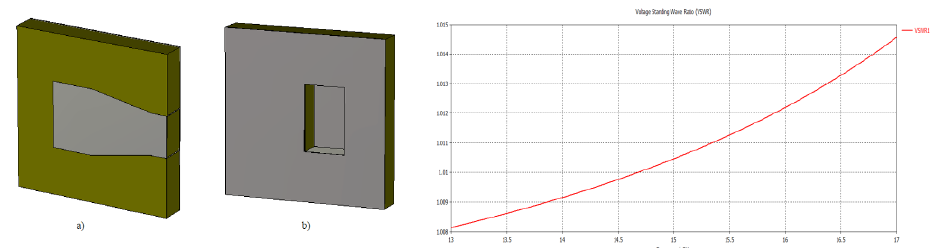
Fig. 6. Dependence of the SWR on the frequency.